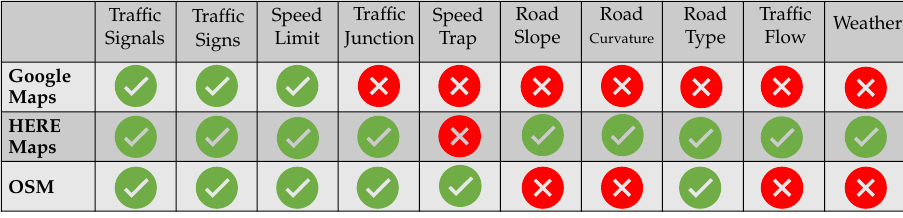
Figure 5. Comparison of three providers for map data